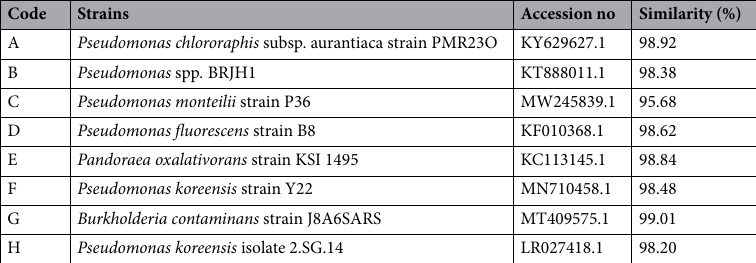
Table 3. The molecular identification of the isolated nitrogen cycling bacteria in soils supplemented with phosphorus and lime, soils rich in phosphorus and control soils collected at Ukulinga farm, KwaZulu-Natal.